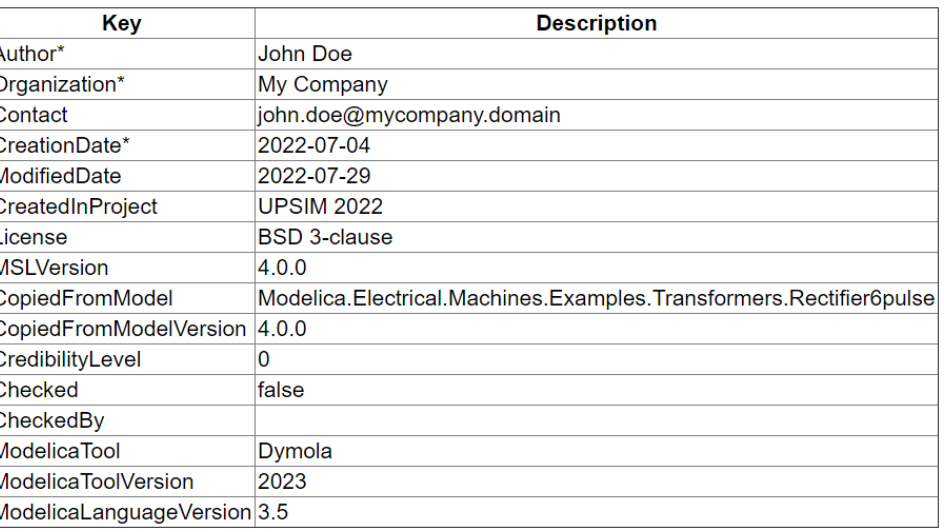
Figure 1. Screenshot of user-defined metadata in Dymola, with a proposed set of keys (* means a required key; otherwise, the key is